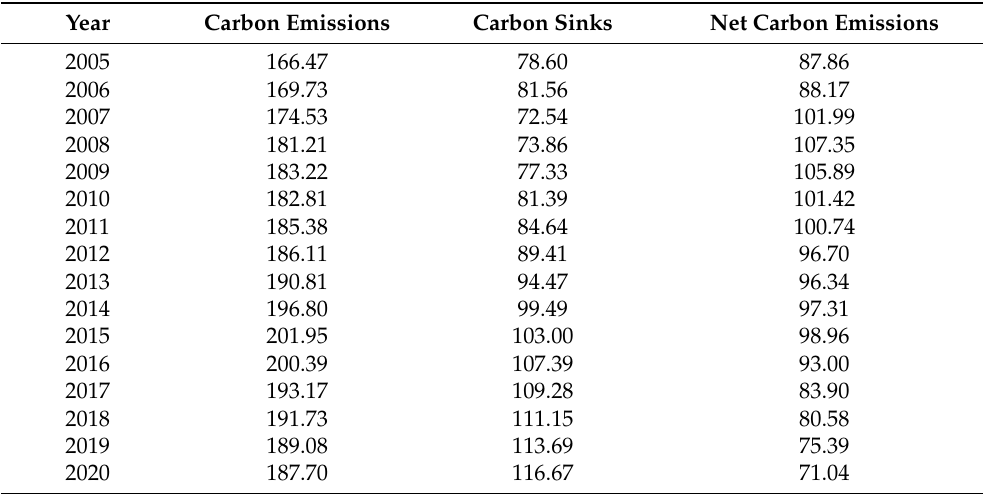
Table 2. Estimation results of net carbon emissions from marine fisheries in China from 2005 to 2020 (10 5